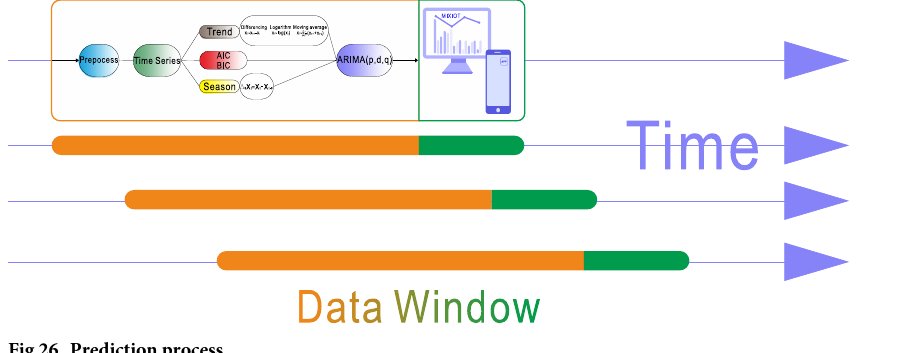
Fig 26. Prediction